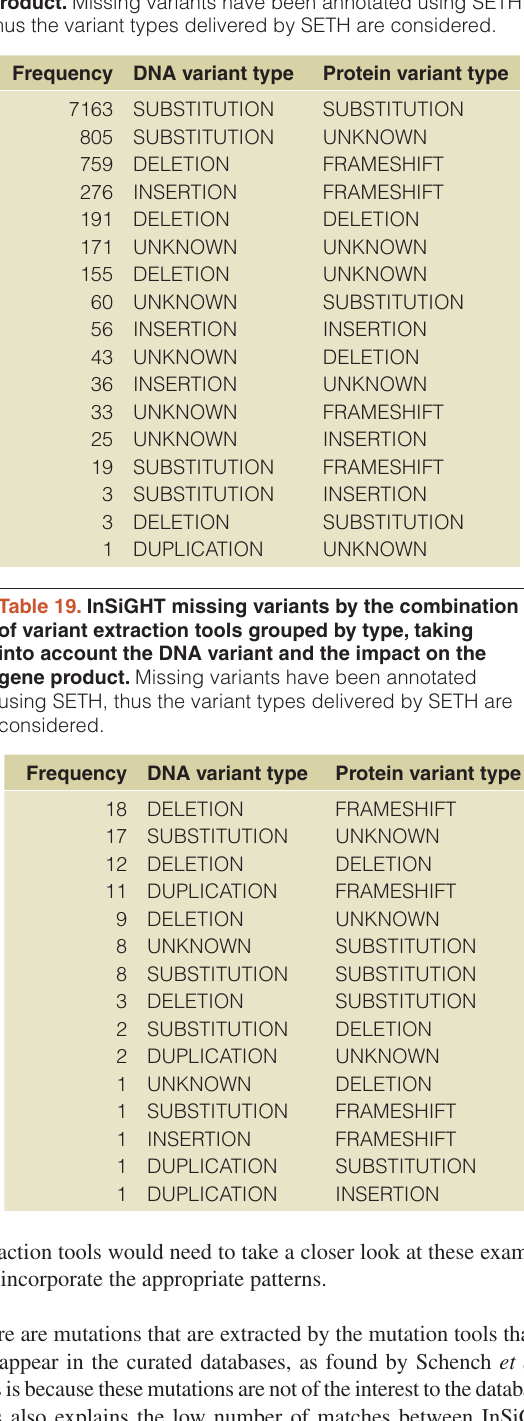
Table 16. COSMIC database variants, taking into account the DNA variant and the impact on the gene product. Variants have been annotated using SETH, thus the variant types delivered by SETH are considered.